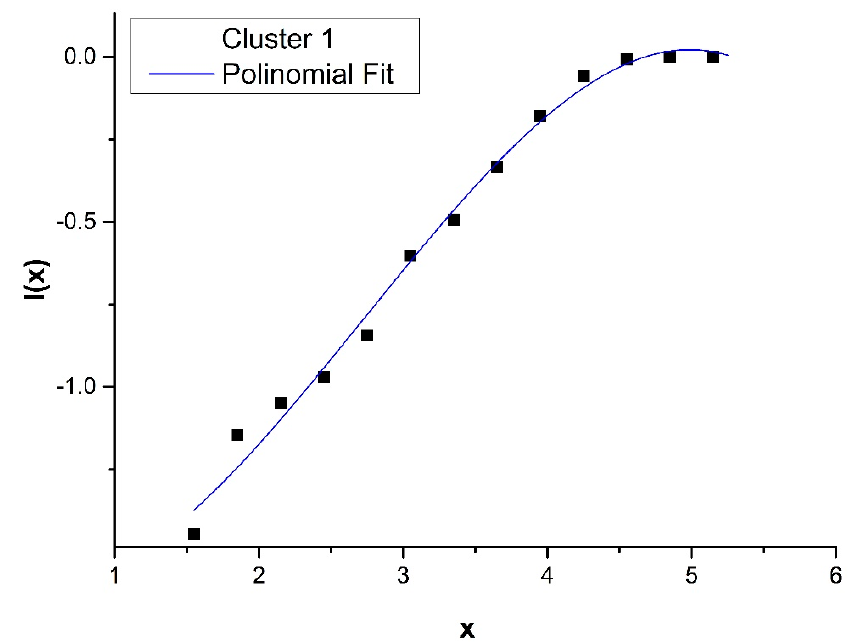
Figure 3. Cumulative distribution I(x) for Cluster 1 fitted using the analytical expression, Equation (1), I(x) = 10 f(x) , where f ( x ) is a polynomial of third degree and x = Log(T T ).